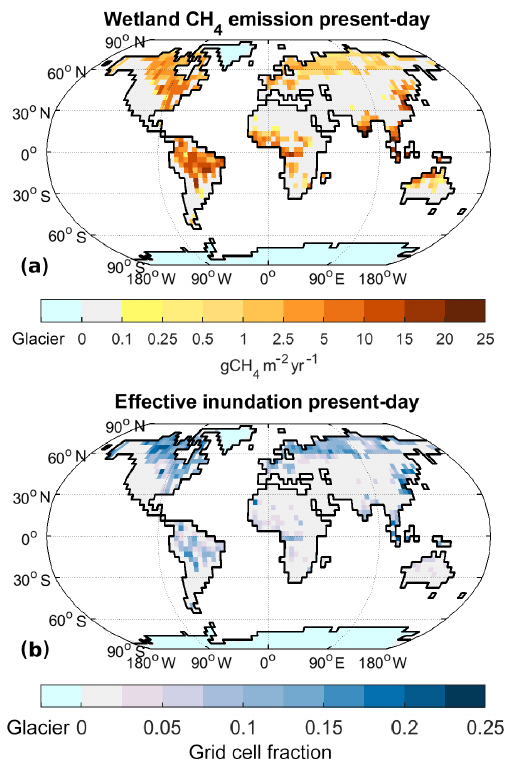
Figure B1. Wetland CH 4 emissions for present-day climate (2000– 2009): annual emissions of CH 4 from wetlands (a) and effective inundation (b) . Please note the different colour scale for (b) in com- parison to Fig. 3.